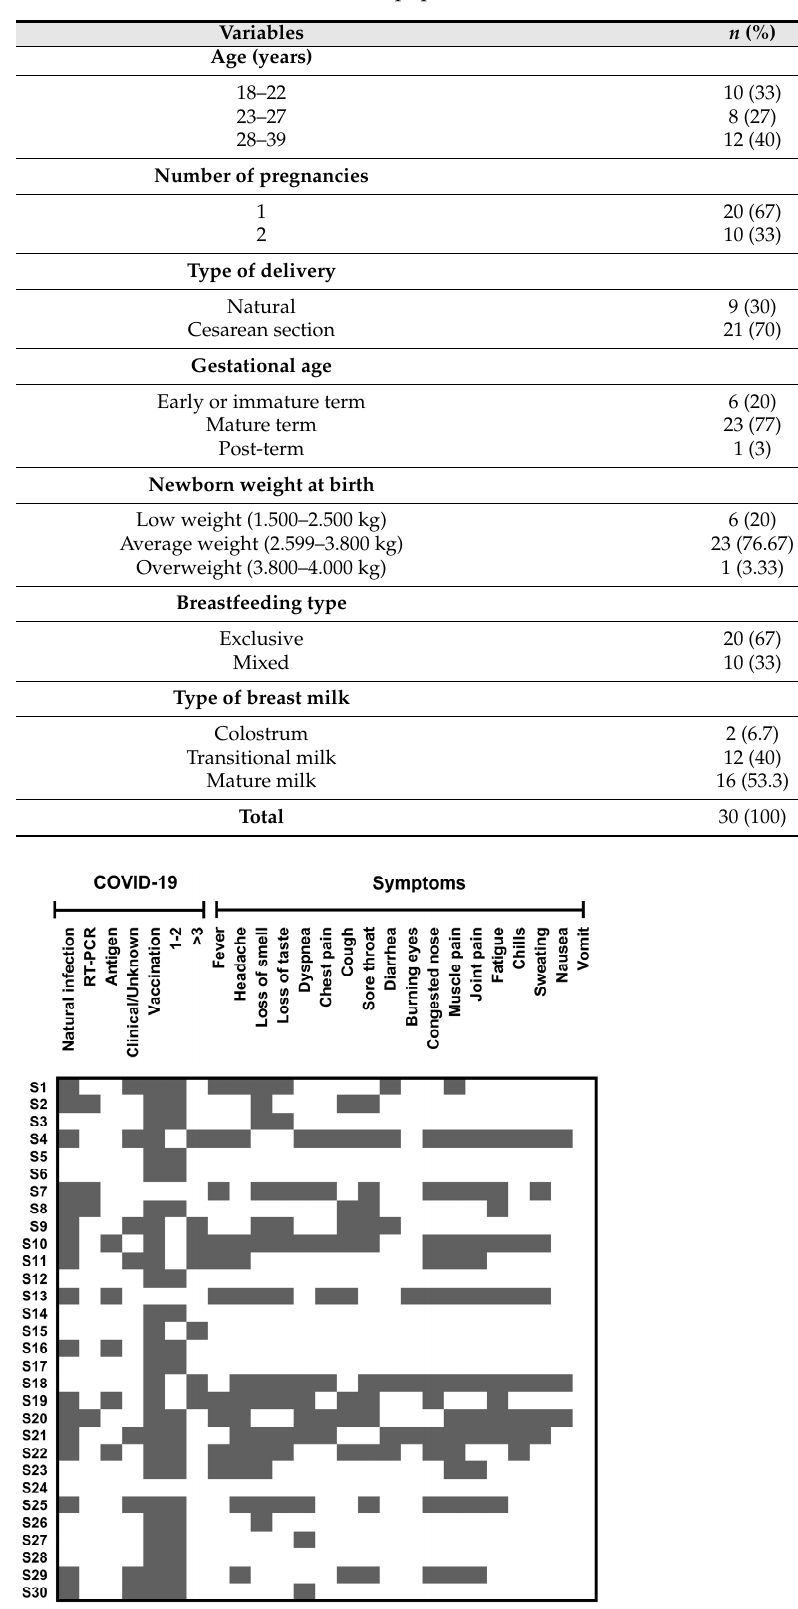
We evaluated the presence of IgA and IgG antibodies against each structural protein of SARS-CoV-2; particularly for the S protein, we used recombinant antigens derived from the S1 domain and RBD for the specific detection of antibodies in the N-terminal domain and glycosylated parts. In breast milk, IgA antibodies against the S1 domain were de- tected in 100% of the samples, 92.59% for the RBD. In relation to N, M, and E, the preva- lence was 76.67%, 90%, and 80%, respectively. For IgG detection in breast milk, all samples tested negative. For the detection of IgA in serum samples, only 36.67% tested positive for the RBD, 13.33% for S1, 16.67% for N, 10% for M, and 16.7% for E. Finally, the detection of IgG in serum samples was as follows: 40% were positive to RBD; 23.3% to S1; 60% to N; 33.33% to M; and 36.67% to E (Figure 2). Later, samples were classified according to posi- tivity only to RBD/S1, positivity to N/M/E, or positivity to antibodies in the S protein and another structural protein to analyze the presence of antibodies related only to vaccination (RBD/S1) or symptomatic or asymptomatic natural infection (N/M/E or RBD/S1/N/M/E). In breast milk, two samples were positive for RBD/S1, three were positive for N/M/E, and 25 tested positive for antibodies in RBD/S1/N/M/E. In serum samples, 17 were negative for IgA, five were positive for RBD/S1, two were positive for N/M/E, and six were positive